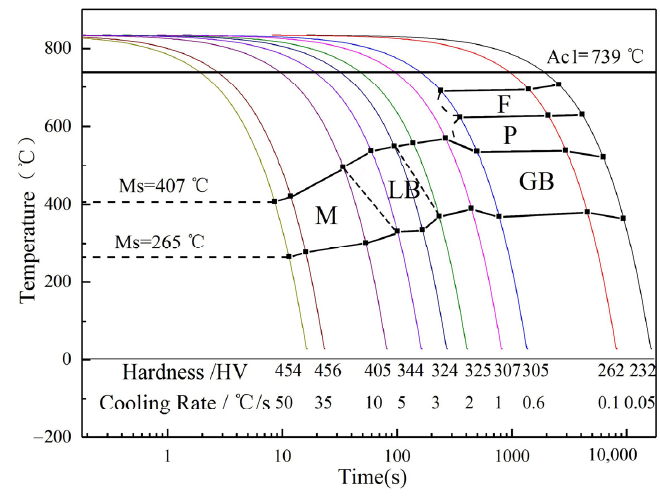
Figure 14. CCT curve in intercritical heat treatment process.